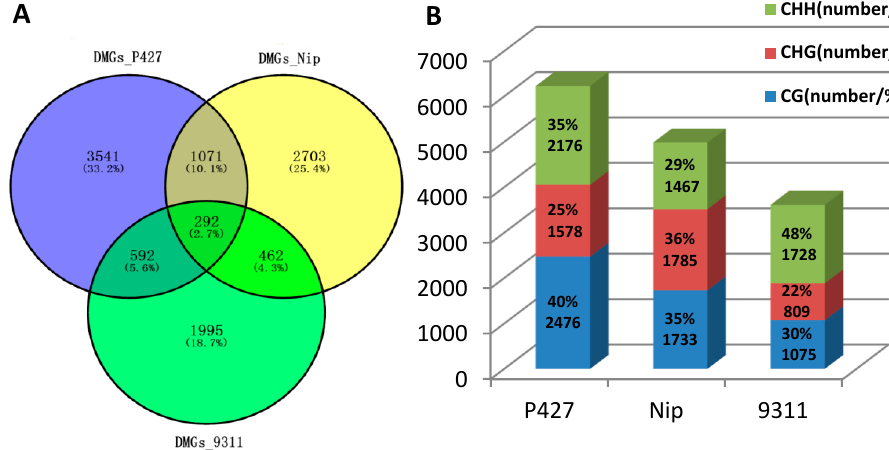
Figure 3. Comparison of DNA Methylation Levels and Loci. ( A ) Venn diagram of methylation genes in the promoter and gene body regions. ( B ) The ratio of methylation site (CHH, CHG, CG) in the promoter and gene body regions.